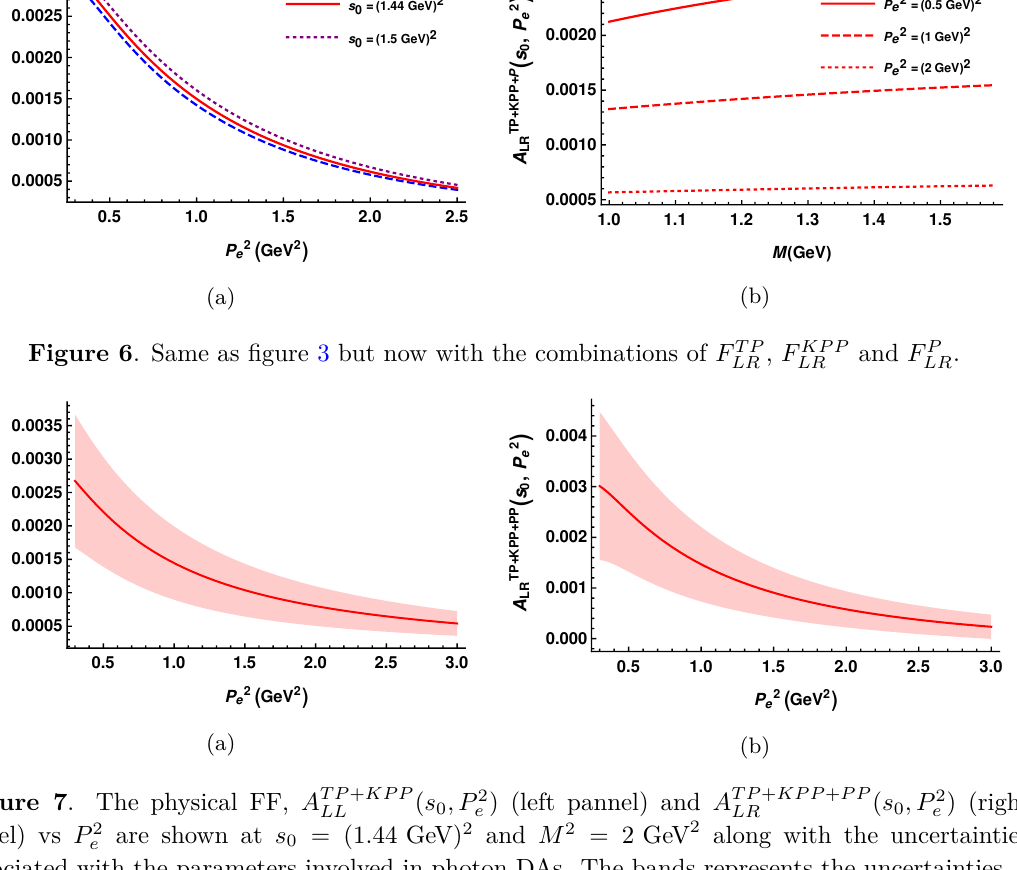
( s ) (right 2 0 , P e LR